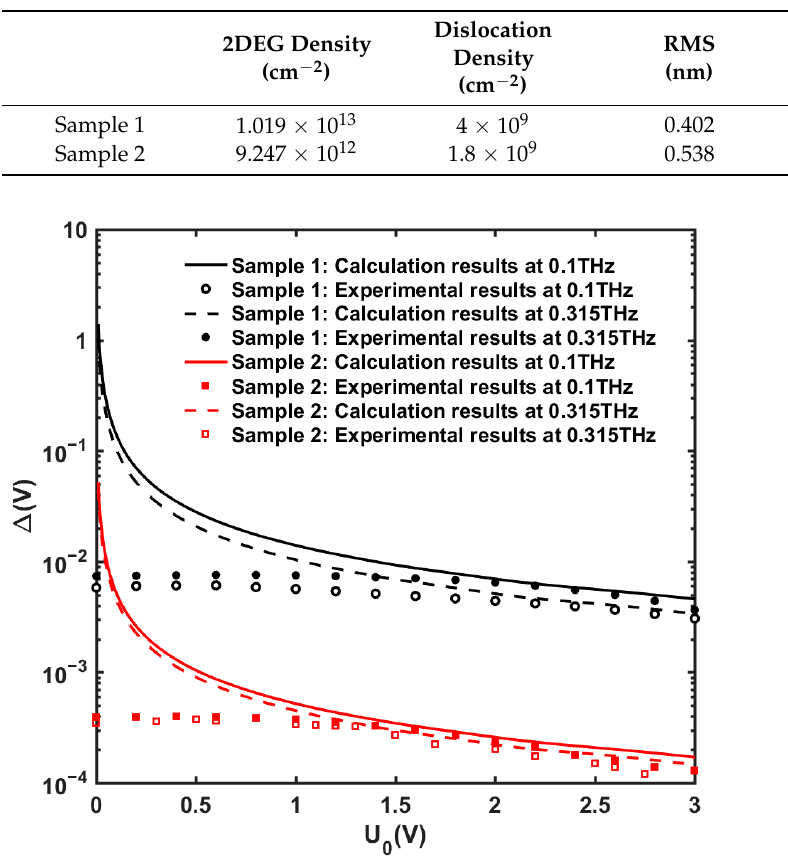
Figure 10. Comparison between experimental results of prepared samples and theoretical calculation results at incident THz radiation frequency of 0.1 THz and 0.315 THz.